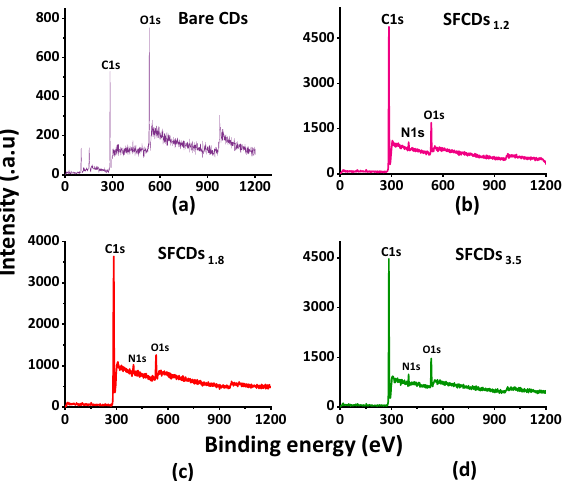
Figure 3. Full scan XPS spectra of ( a ) bare CDs ( b ) SFCD1.2 ( c ) SFCD1.8 ( d ) SFCD3.5, reveals C1 s and O1 s bands at 284.6 and 531.5 eV respectively. In addition, N1 s band at 399.5 eV in SFCDs ( b – d ) indicate successful nitrogen doping in the fabricated